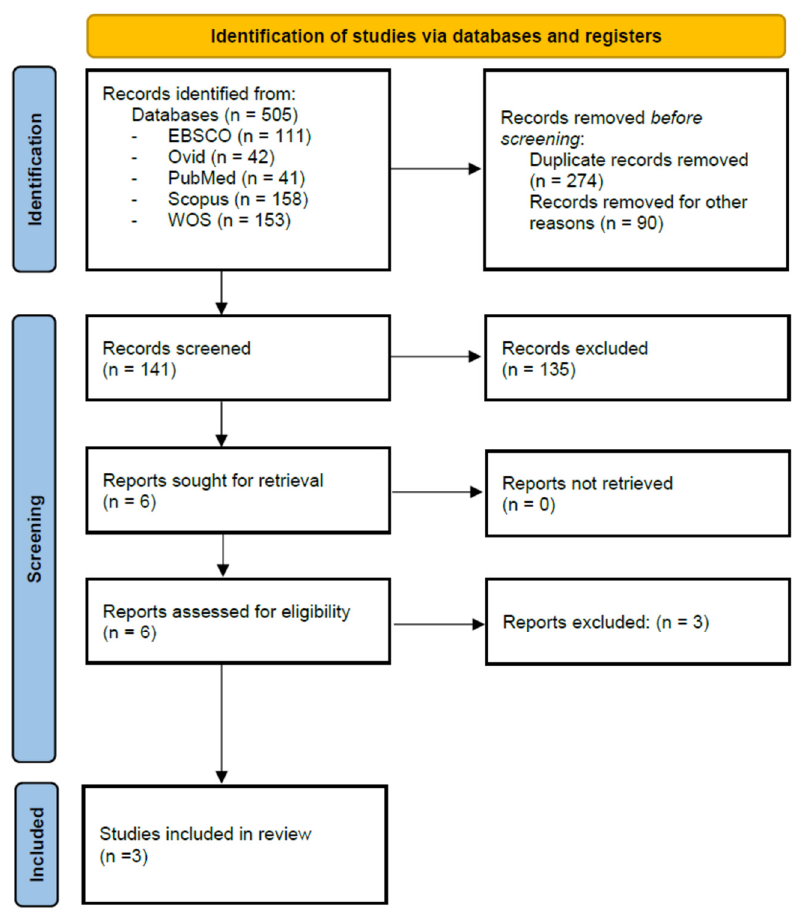
Figure 1. Systematic review of the literature flowchart.